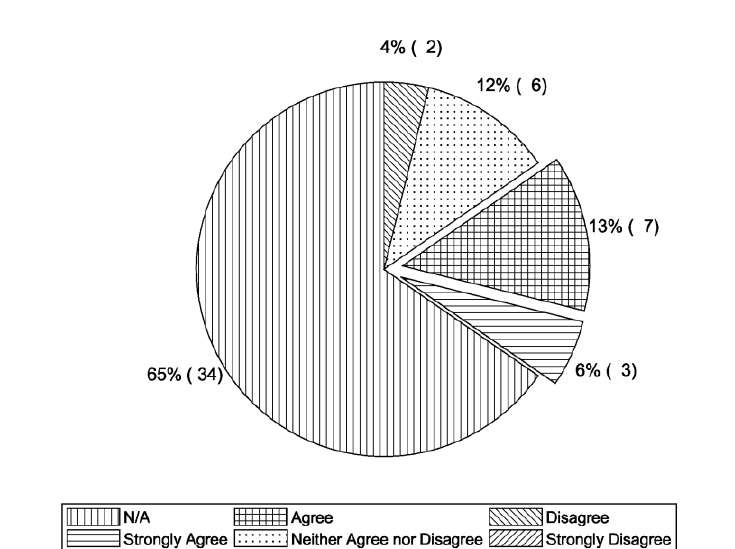
Fig. 12. Projects affect students who did not intend to study engineering before taking this course to decide to study